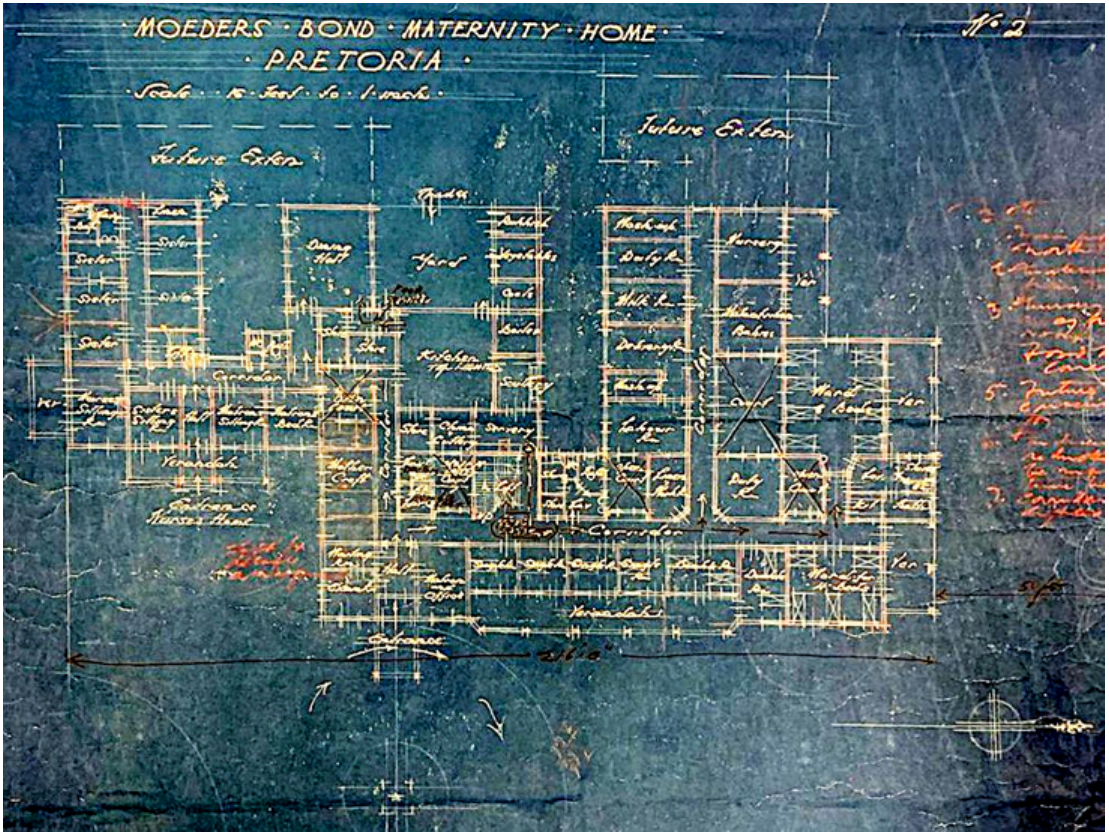
Figure 4. Annotated floor plan of the Moedersbond Maternity Home. Note the arrow pointing north arrow in the bottom right corner (Source: Architecture Archive, University of Pretoria, John Cleland Collection)